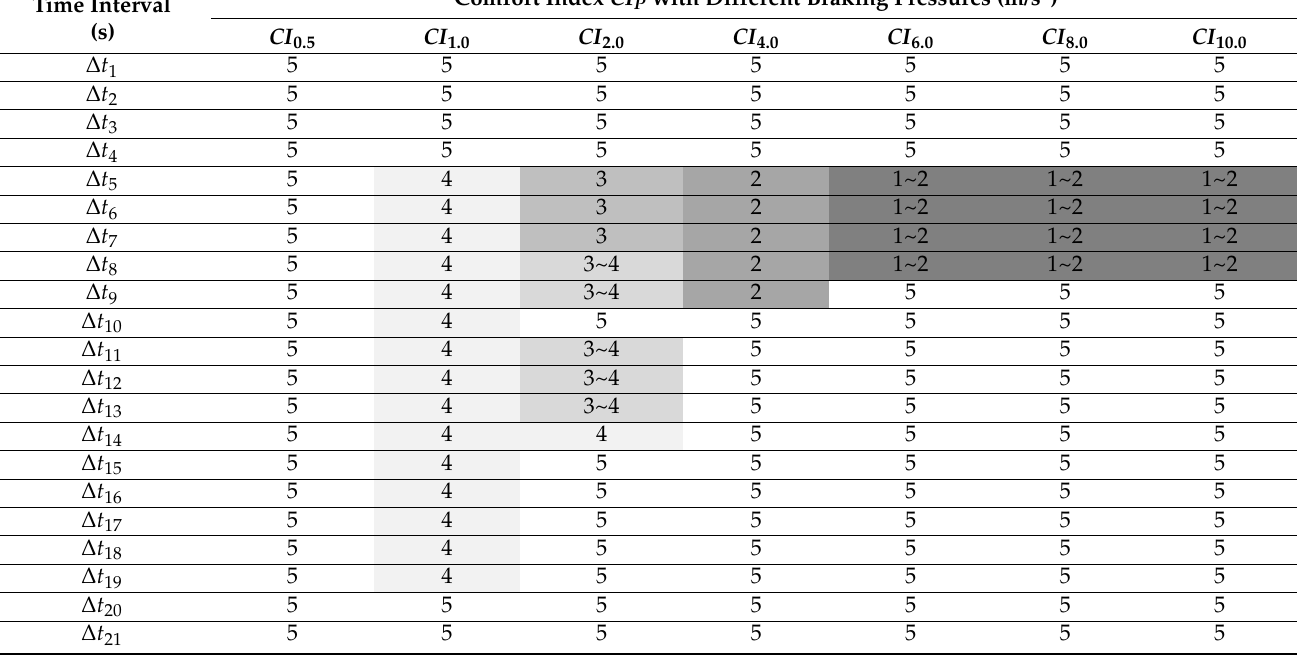
Table 5. Comfort level of emergency braking on a dry